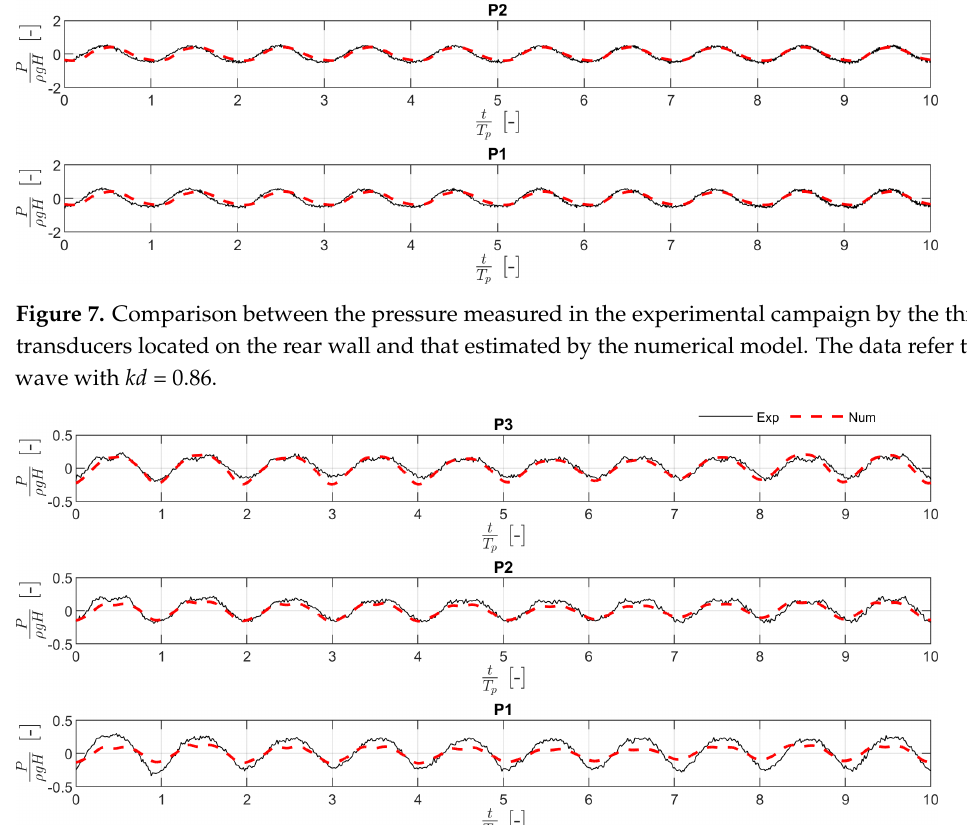
Figure 8. Comparison between the pressure measured in the experimental campaign by the three transducers located on the rear wall and that estimated by the numerical model. The data refers to a wave with kd =